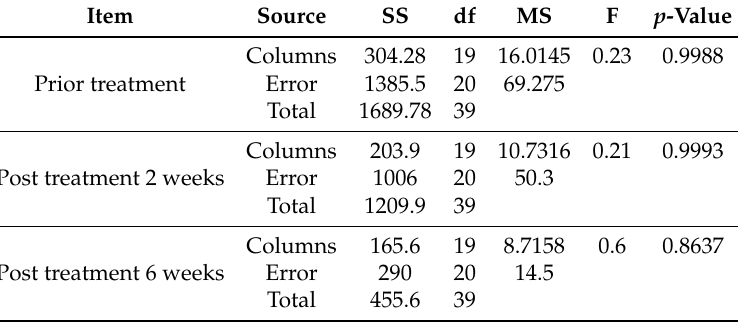
Table 7. Analysis of variance (ANOVA) table of bilateral knee range of motion (ROM) for a stroke